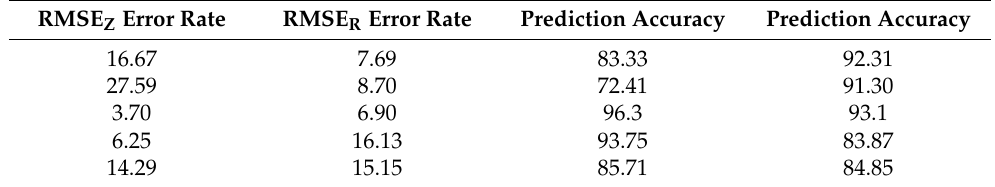
Table 8. Prediction Error Rate and Accuracy of Butner UAS Test Site from Pix4D and MR Models. RMSE Z Error